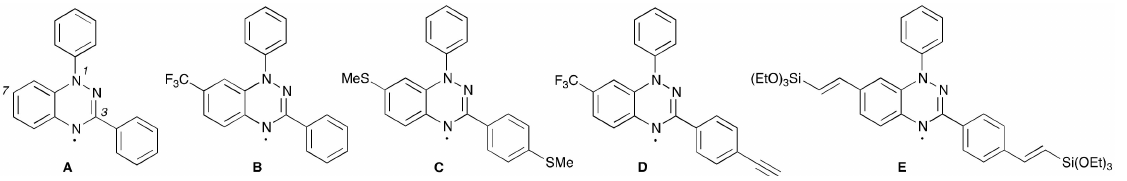
Figure 1. The structure of the prototypical Blatter radical ( A ), the “super stable” derivative ( B ), and functional derivatives ( C – E ).